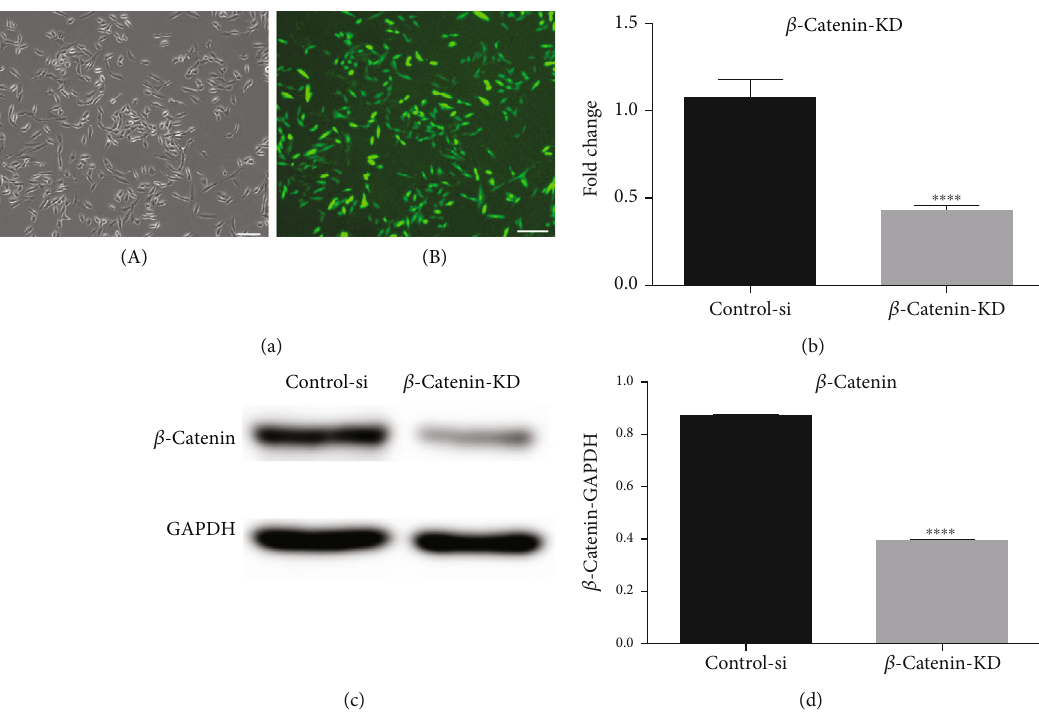
Figure 7: (a) A green fl uorescence protein marker was used to determine the transfer e ffi ciency of β - catenin knockdown in SHEDs (SHED- si). After transfection for 72 h, cells were observed under a (A) contrast phase microscope and an (B) immuno fl uorescence microscope. Scale bar, 100 μ m. (b) qRT-PCR analysis was performed to detect β - catenin expression. (c) WB was conducted to determine β -catenin. (d) Quanti fi cation of β -catenin protein levels. ∗ p < 0 : 05 vs. the control-si